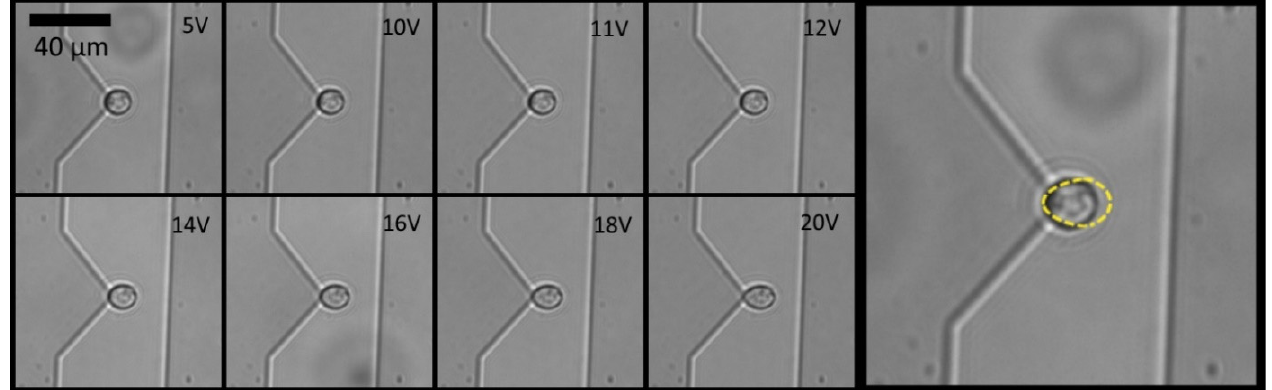
Figure 2. THP-1 cell captured at electrode tip by DEP forces and subsequently deformed. Right side shows an overlay of the 20V deformation on top of the resting cell. Supplementary Materials contain the movie file of this process.